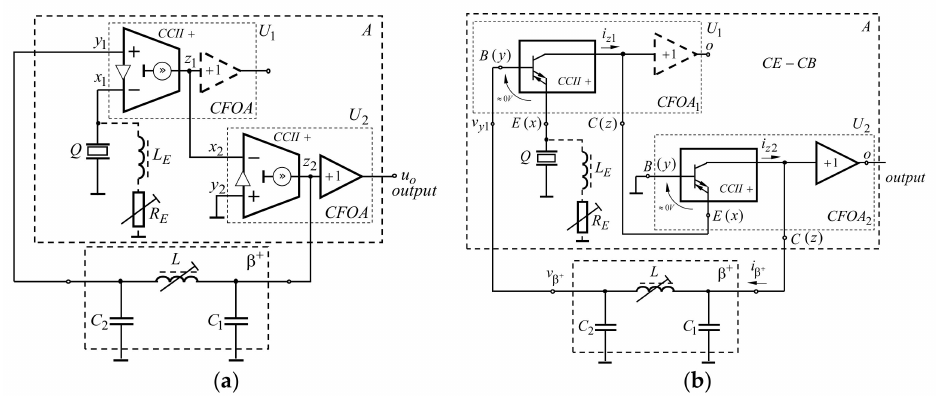
Figure 5. Two-stage oscillator, with the quartz-crystal unit used as an unbypassed load of x terminal on Ul (QO2): ( a ) circuit diagram with two CCIIs, represented as parts of four-terminal CFOAs; ( b ) circuit diagram with two CCIIs, represented as a cascode (common emitter–common base)